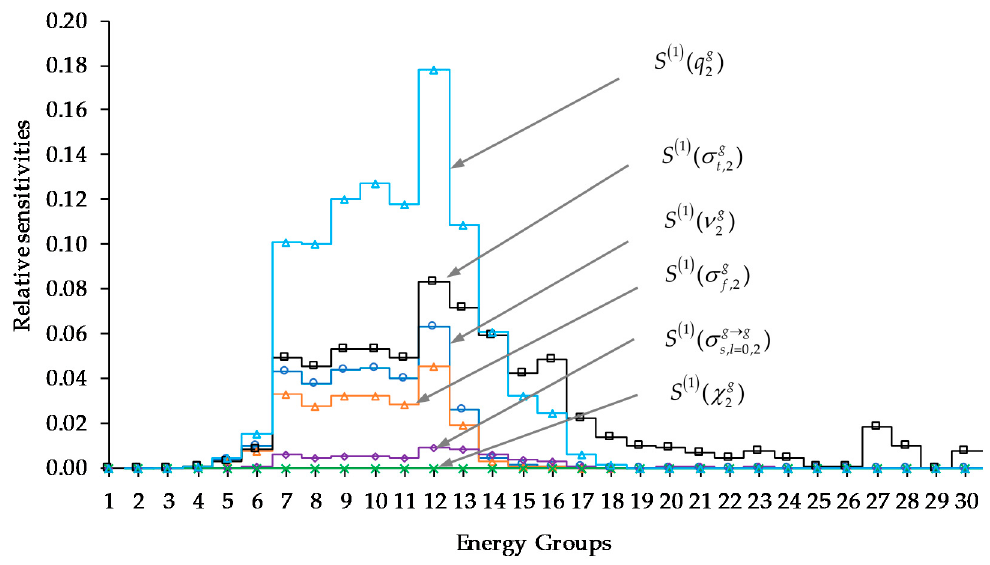
Figure 4. Comparison of first-order relative sensitivities for isotope 2 ( 240 Pu).